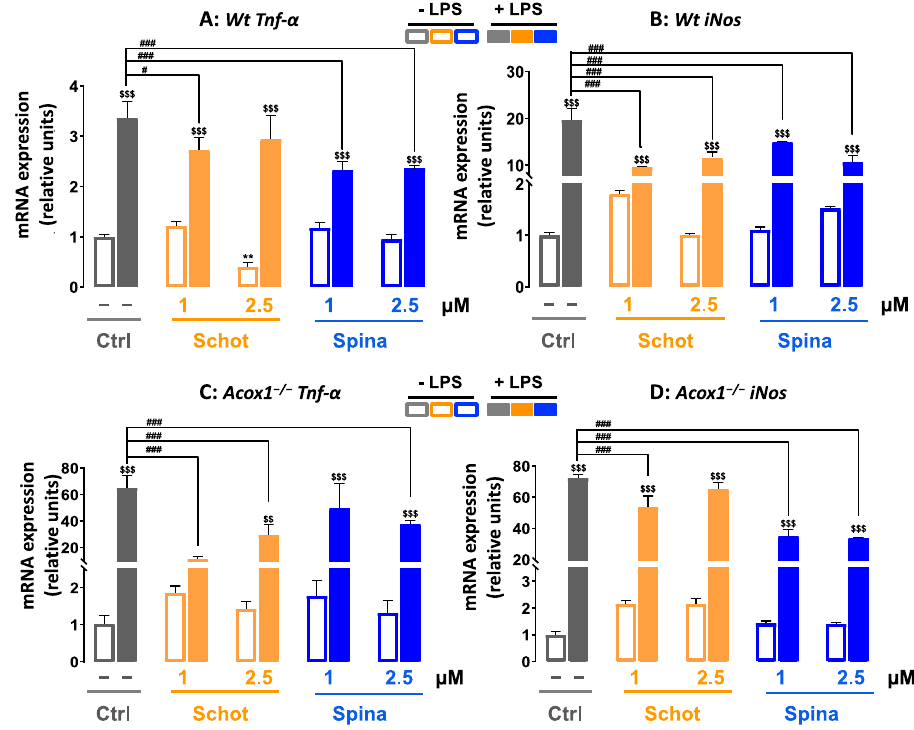
Figure 9. Effect of Schot and Spina treatments on the gene expression of the proinflammatory markers Tnf- α ( A , C ) and iNos ( B , D ) in Wt ( A , B ) and Acox1 − / − ( C , D ) BV-2 microglial cells. Cells were incubated for 24 h with Schot or Spina (1 or 2.5 µ M) in the absence or presence of LPS (1 µ g/mL). Total RNA was isolated from BV-2 cells, and then the expression level of genes of interest was quantified by real-time RT-qPCR. All values are presented as means ± SD of two independent experiments performed in triplicate, with the statistical significance of the increased mean signal indicated as ** p ≤ 0.01 compared to control; ### p ≤ 0.01 and # p ≤ 0.05 compared to LPS; $$ p ≤ 0.01 and $$$ p ≤ 0.001 compared to the different treatments with or without LPS administration. Statistical significance was determined using two-way ANOVA followed by Tukey’s test for multiple comparisons.